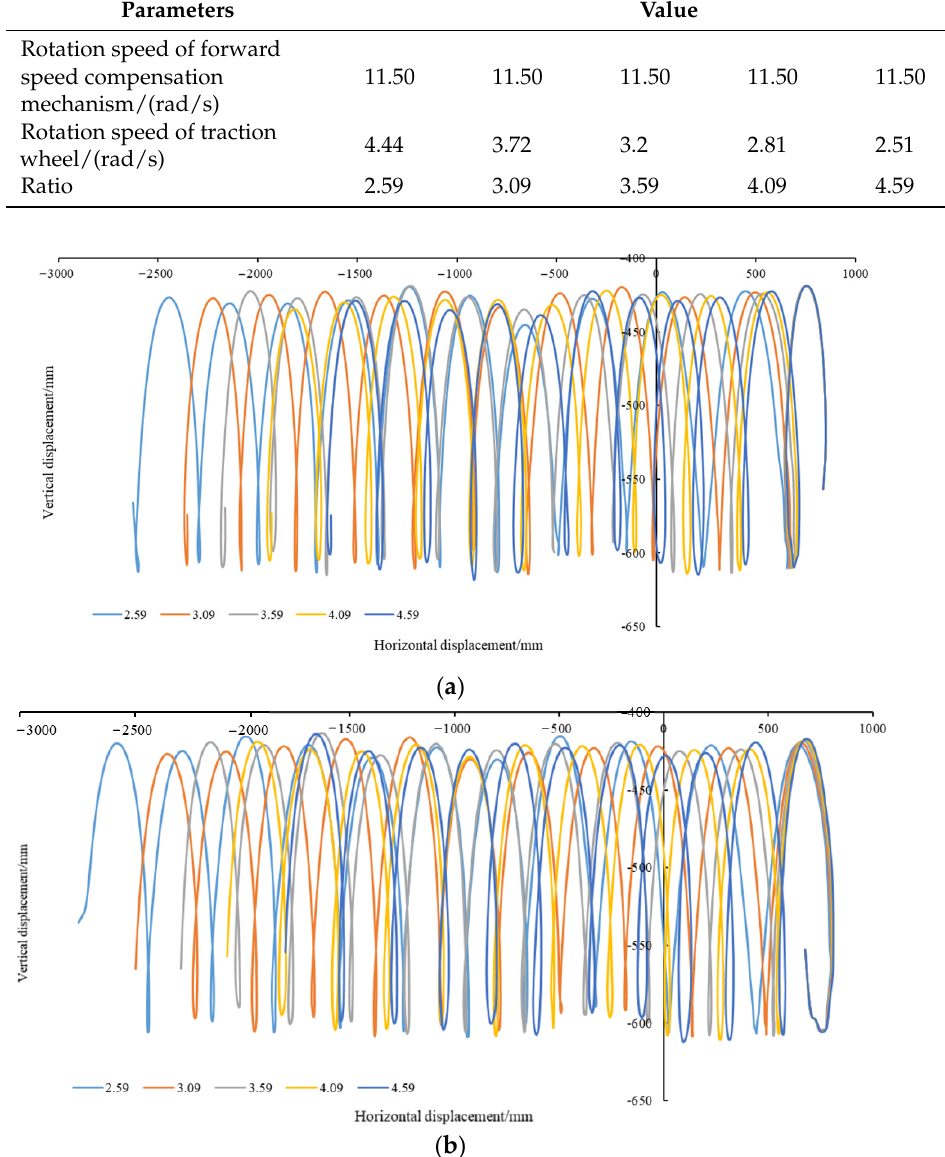
Figure 11. Trajectory of cavity seeders under different rotation speed ratios. ( a ) Right cavity seeder. ( b ) Left cavity seeder.